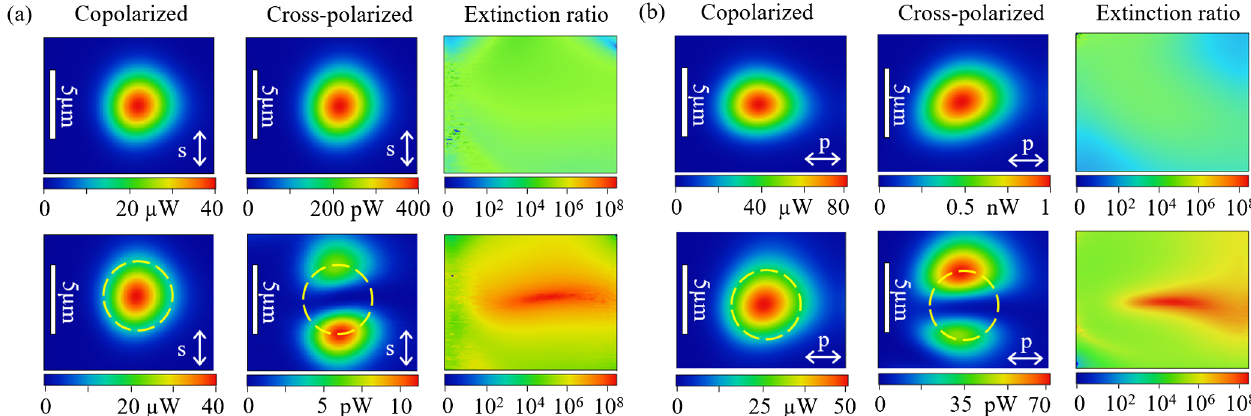
FIG. 2. Confocal mapping of s (a) and p (b) laser beams in co- and cross-polarization using a scanning mirror (9). The upper and lower rows of the figures are measurements with the analyzer placed before [Fig. 1(a)] and after [Fig. 1(b)] the test reflecting surface, respectively, in s polarization and p polarization [(a) and (b), respectively]. We plot the extinction ratio map by dividing, pixel per pixel, the copolarized with the cross-polarized data. In cross-polarization, a modal splitting along ⃗ e y above and below the plane of incidence is observed for both the s and p polarization. The dotted line circle is the 1 =e intensity level of the Gaussian distribution resulting from the confocal convolution between the focused spot and the collecting fiber mode. The location of the maxima of the modal splitting lies exactly on that circle. The diameter of this circle gives also the nonconvoluted focal spot waist diameter at 1 =e 2 focused on the collecting fiber end. The vertical white bar represents 5 μ m.